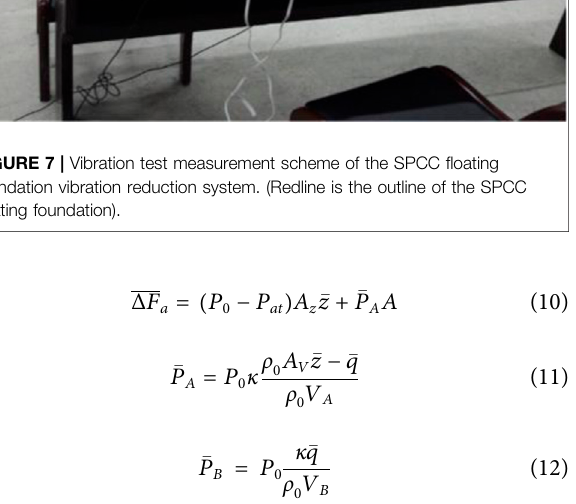
FIGURE 8 | Comparison of acceleration time histories for the SPCC fl oating foundation vibration reduction system obtained via simulations and